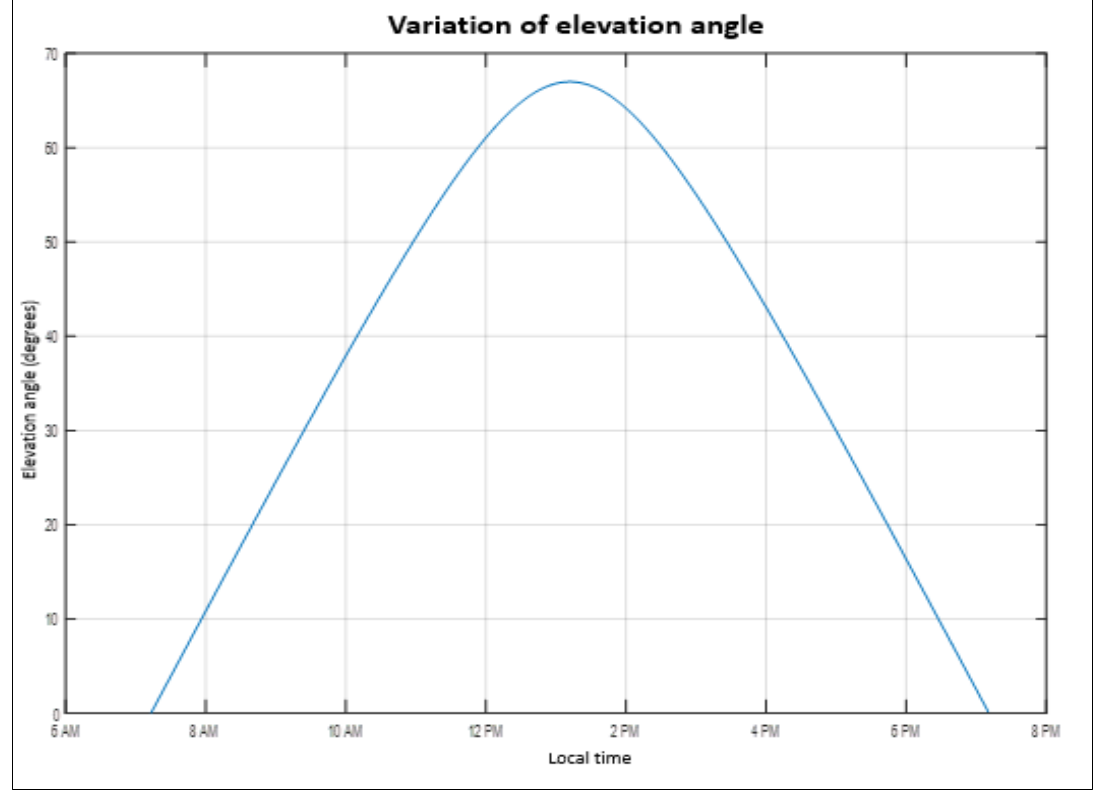
Figure 18: Behavior of the solar elevation angle.